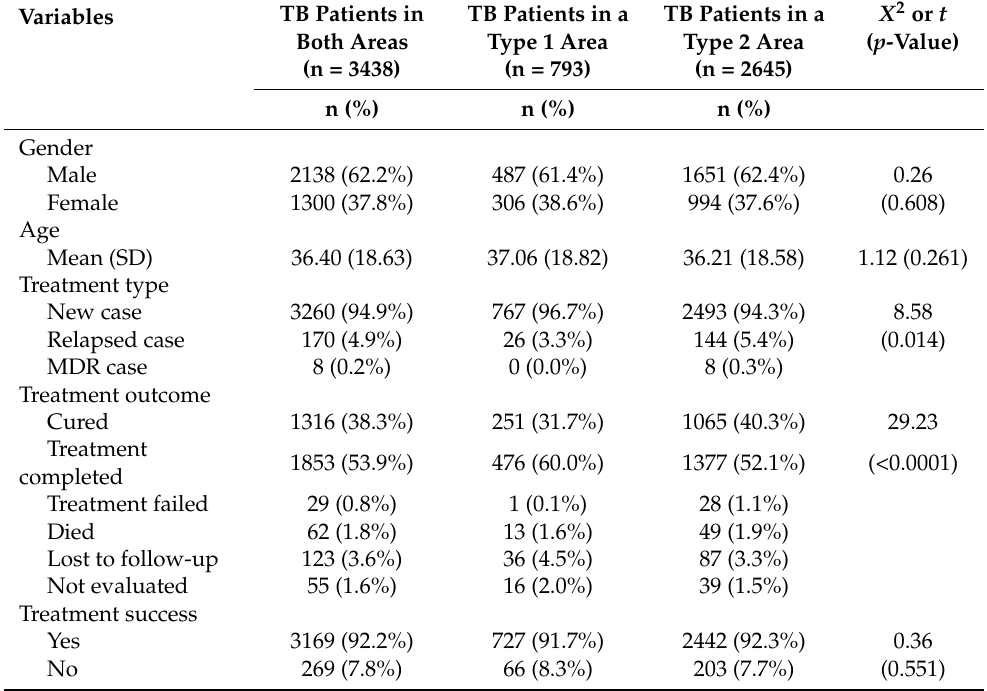
Table 1. Baseline characteristics and treatment outcomes of TB patients (January 2018–December